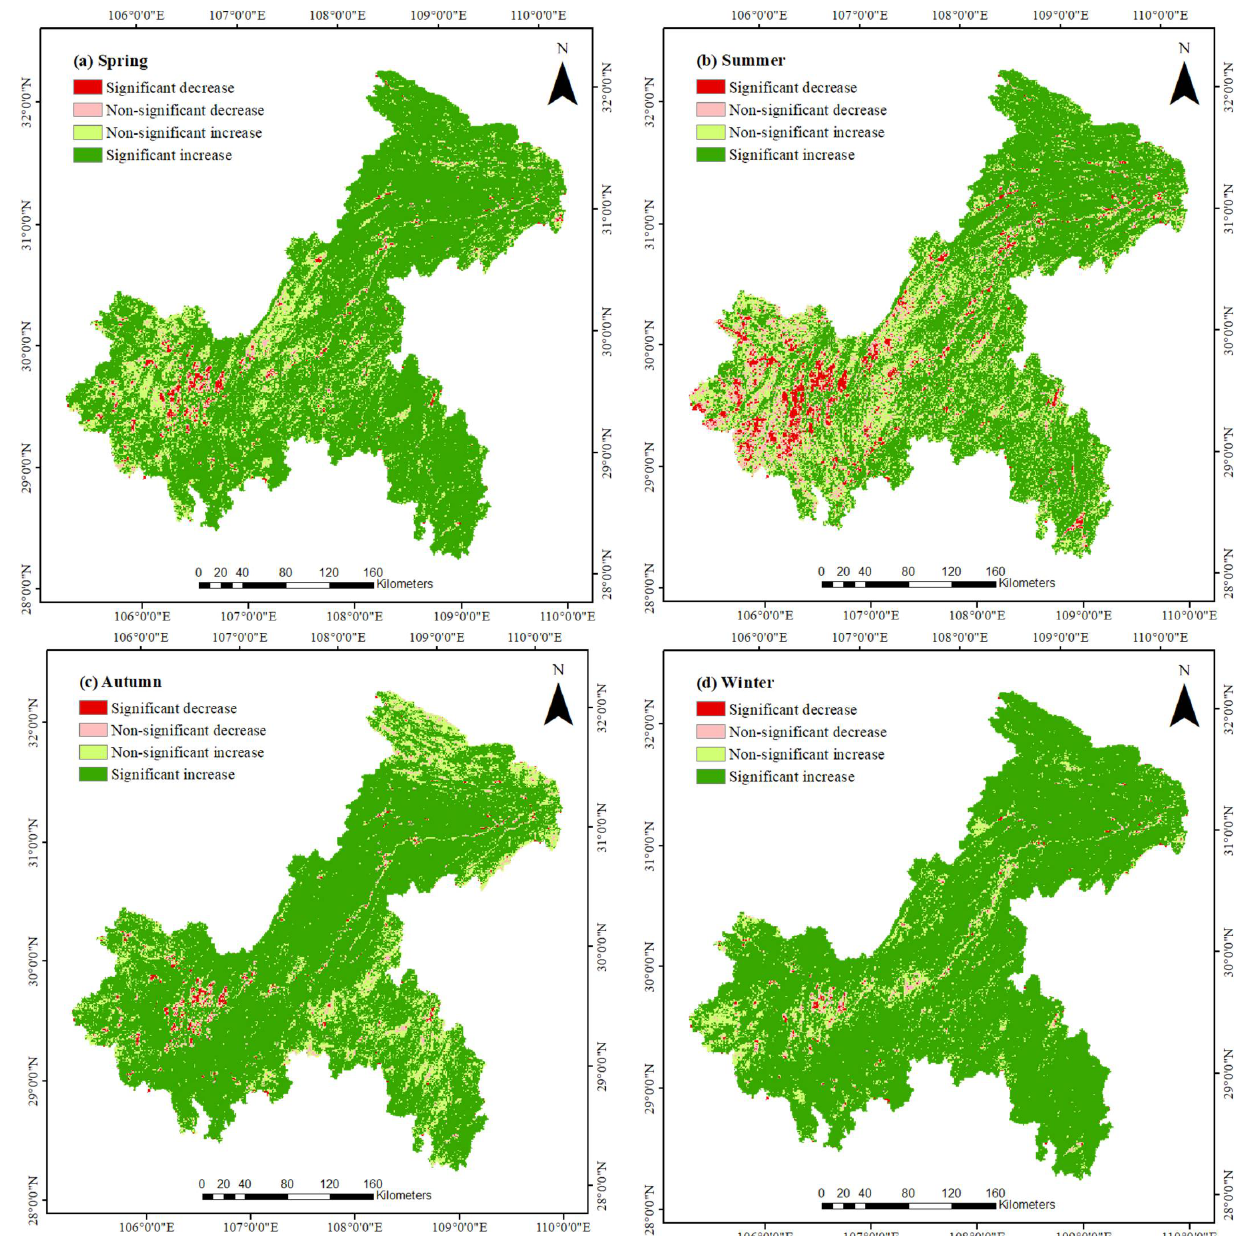
Figure 5. Changes in vegetation cover over the seasons: ( a ) spring, ( b ) summer, ( c ) autumn, and ( d ) winter. ( d ) winter.